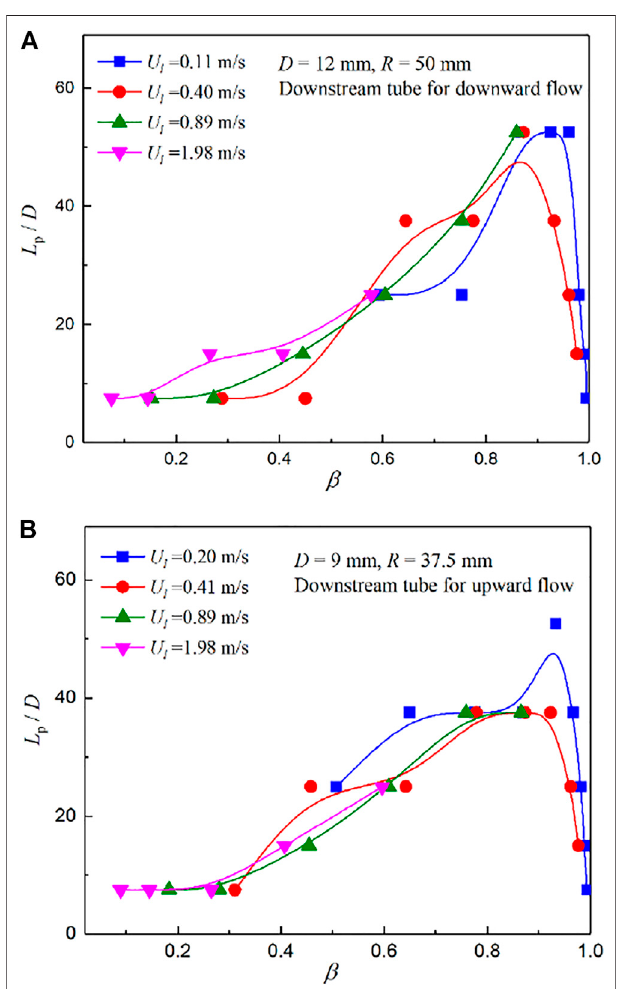
FIGURE7| Effectoftheinletvolumevoidfraction β onthedimensionless perturbation length L p / D . (A) Downstream tube for downward fl ow, D = 12 mm,R=50 mmand (B) Downstreamtubeforupward fl ow,D=9 mm,R= 37.5 mm.